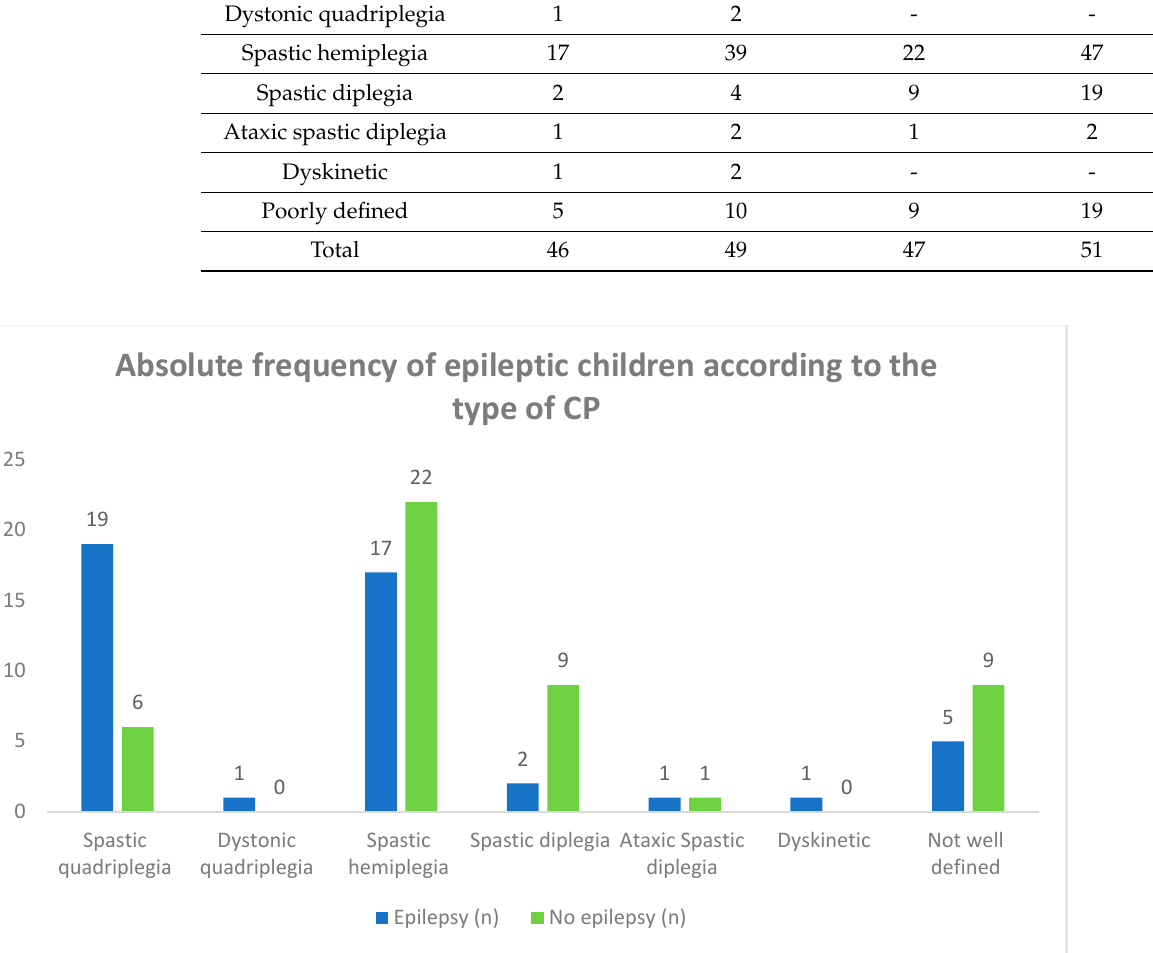
Figure 3. Absolute frequency of epileptic children according to the type of CP. Figure 3 . Absolute frequency of epileptic children according to the type of CP. Furthermore, in the comparison between children with spastic quadriplegia and those with spastic hemiplegia, the frequency of epilepsy was significantly higher in the former (46% vs. 39%; p = 0.02). As in the comparison with the children with spastic diplegia, the frequency was significantly higher in the quadriplegic children (46% vs. 4%; p = 0.002). Instead, no statistically significant difference was found in the comparison between hemiplegic and diplegic